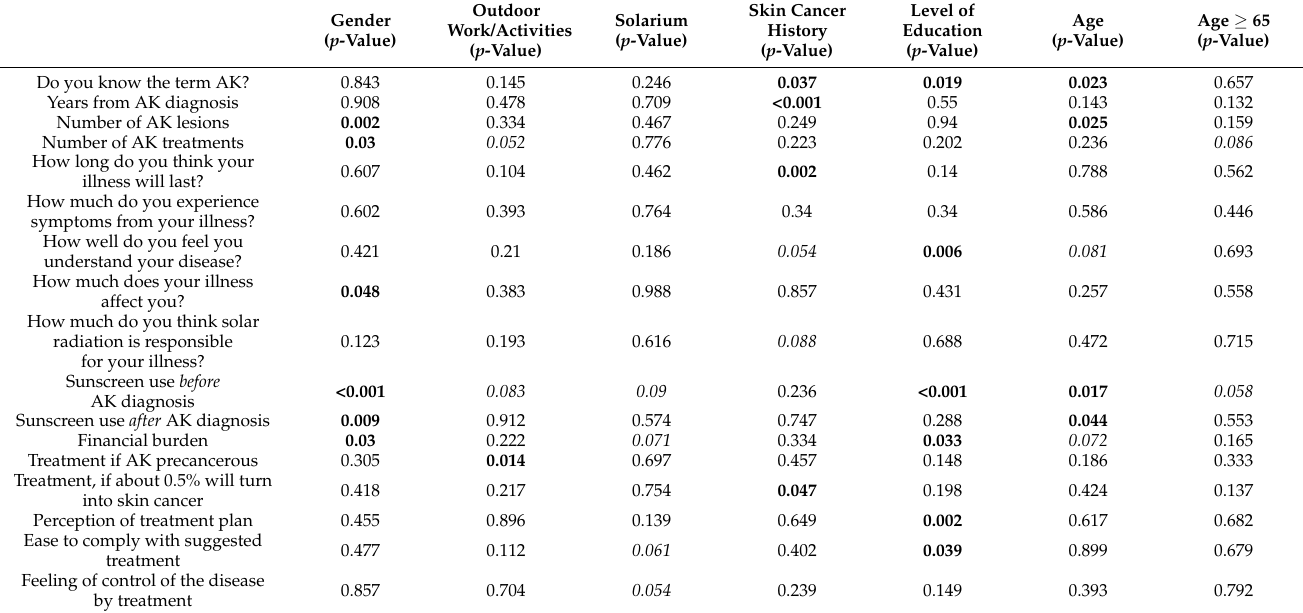
Table 5. Correlations of illness and treatment perception questions with patients’ demographics and